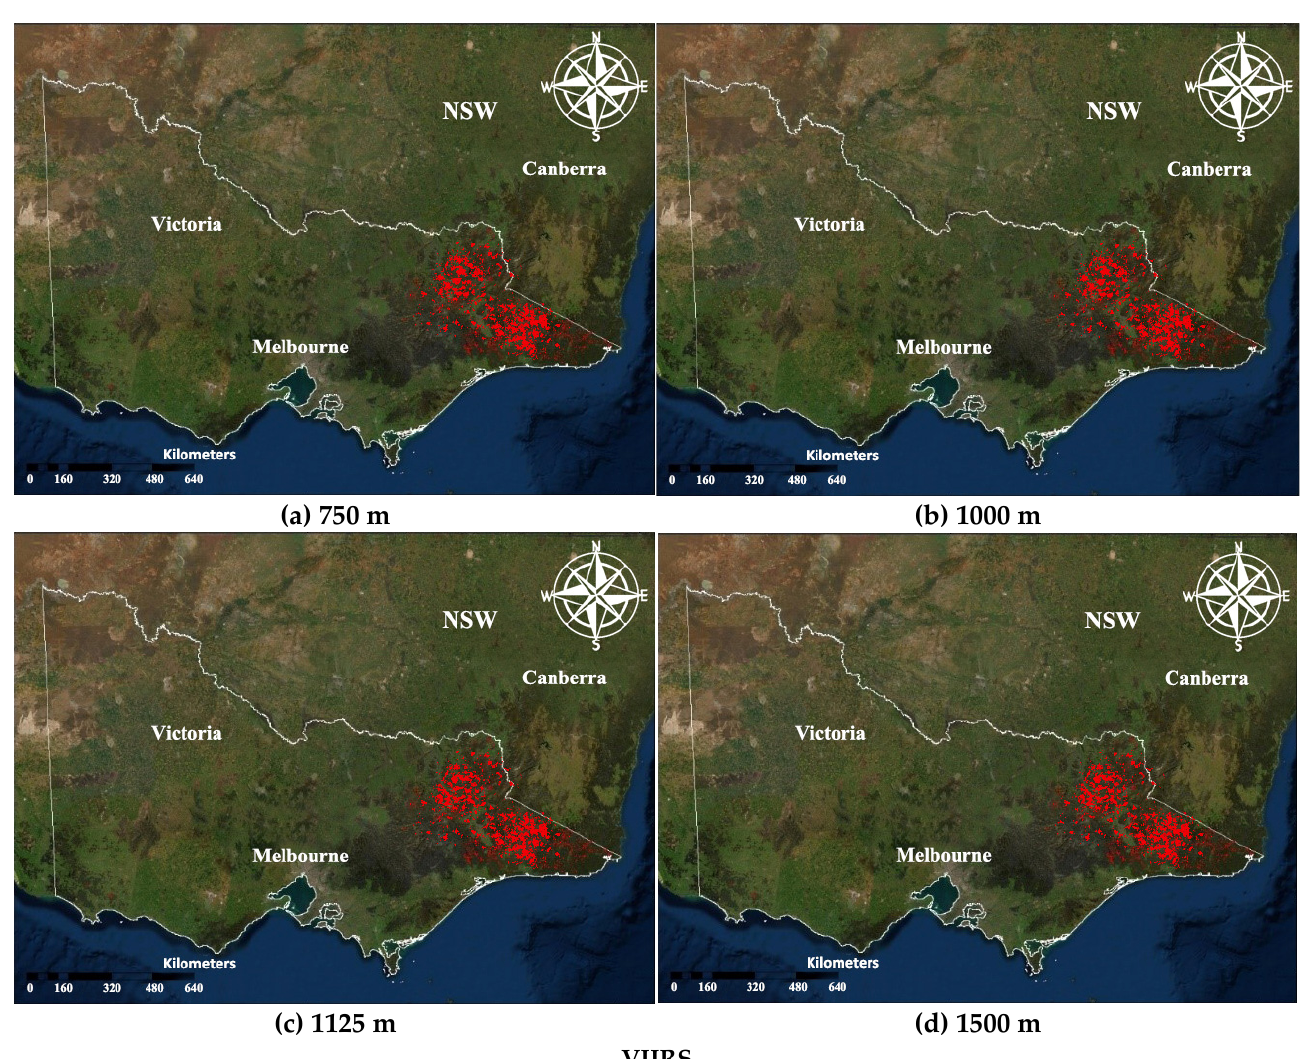
Figure 11. Aggregate perimeters identified from the VIIRS active fire products using the distances of (a) 750 m, (b) 1000 m, (c) 1125 m, (d) 1500 m.